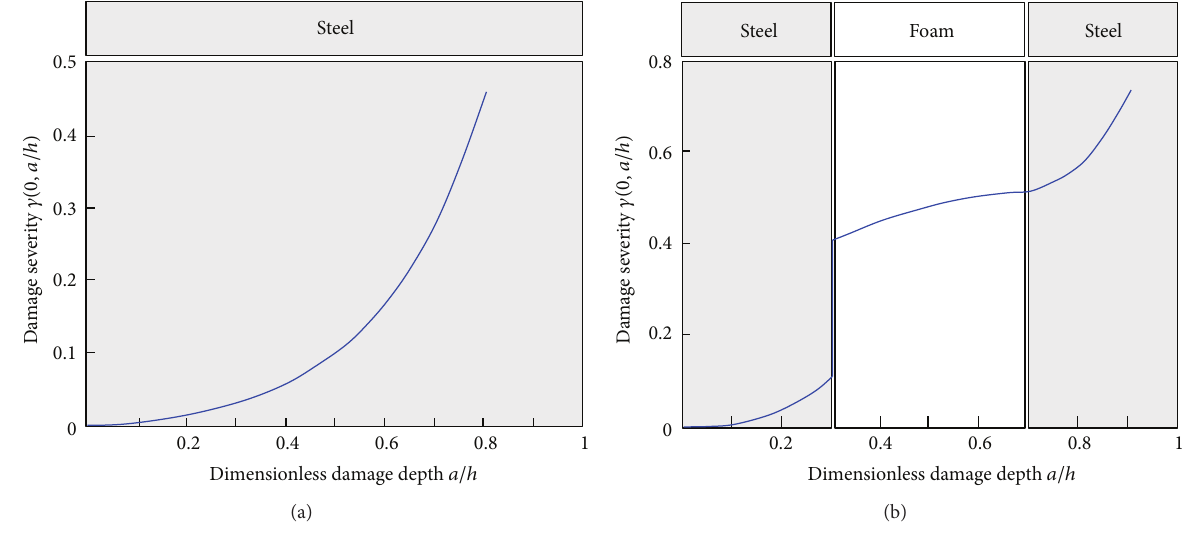
Figure 5: Damage severities versus dimensionless damage depth for (a) the steel beam and (b) the sandwich beam.